Question: What does this figure show? Answer in one sentence.
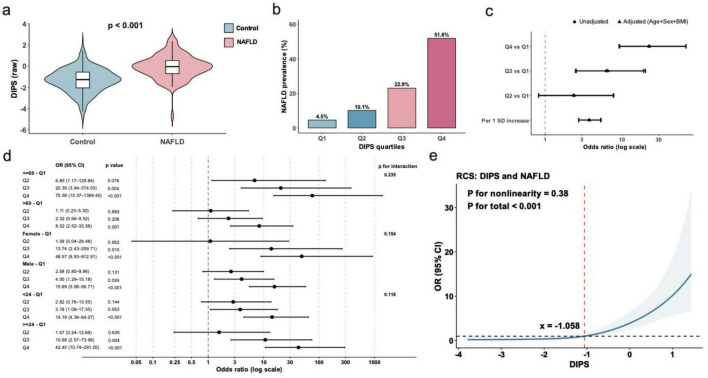
Answer: Association between DIPS and NAFLD in the local cohort. (a) Distribution of DIPS (raw) values in control and NAFLD groups. (b) Prevalence of NAFLD across DIPS quartiles. (c) Odds ratios for NAFLD according to DIPS levels (unadjusted and adjusted for age, sex, and BMI). (d) Subgroup analyses stratified by age, sex, and BMI (e) Restricted cubic spline analysis of the association between DIPS and NAFLD, adjusted for age, sex, and BMI.